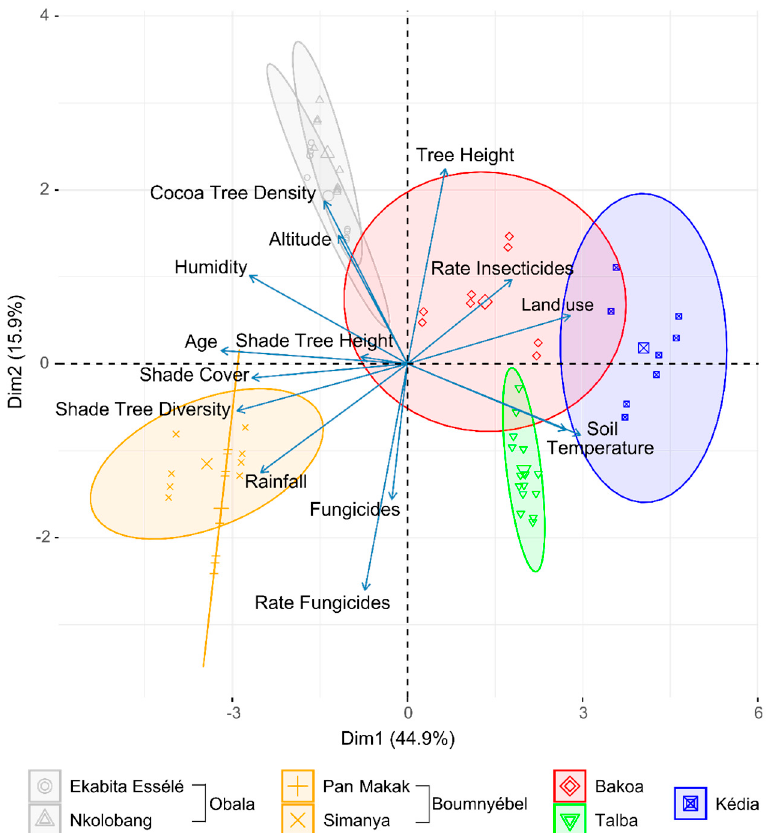
Figure 1. Biplot of the Principal Component Analysis (PCA) based on Euclidean distances. Comparison of the seven sampling sites in Cameroon by environmental characteristics and agroforestry management. The first two principal components (PC) explained 60.8% of total variation in the data. For further explanation on environmental data, see Supplementary Table S1.